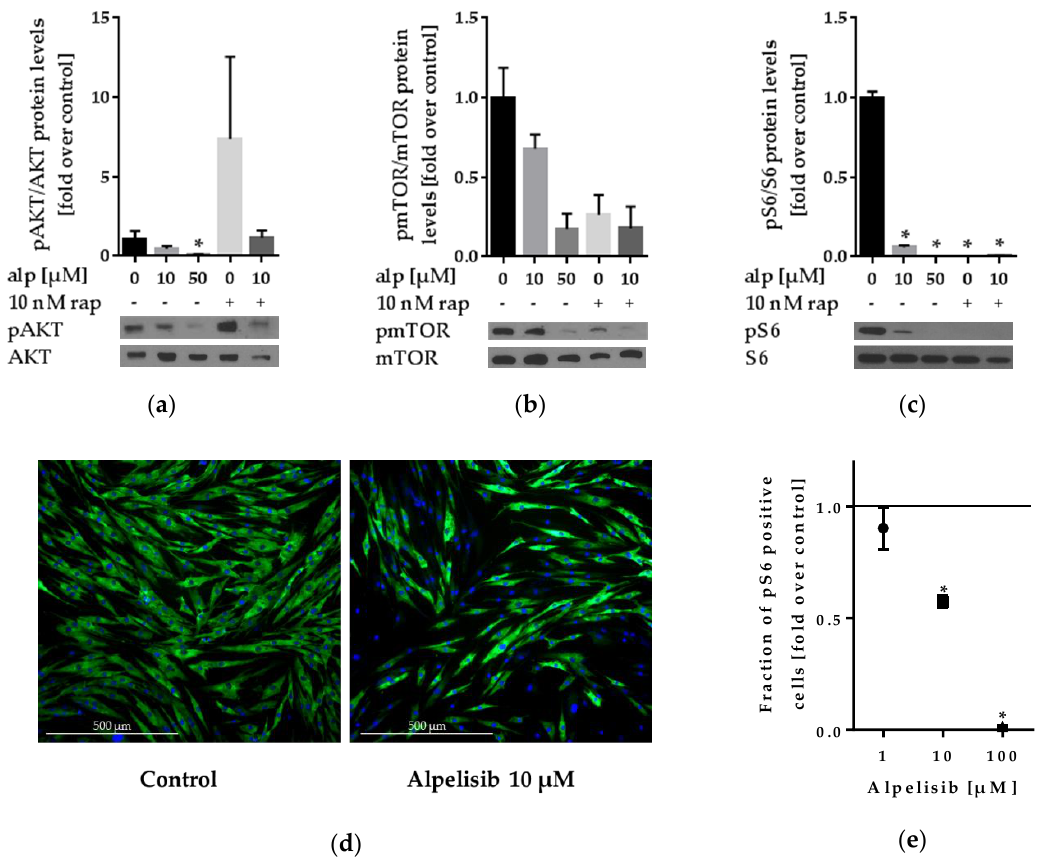
Figure 4. Western blot analysis of LipPD1 cells after 24 h treatment and pS6 immunofluorescence staining after 48 h treatment with alpelisib (alp) and/or rapamycin (rap), representative blots and densitometric analysis: ( a ) Phosphorylated AKT (phospho-Thr 308 (pAKT) normalized to total AKT) was reduced after alpelisib but not rapamycin treatment; ( b ) phosphorylation of mTOR (phospho-Ser 2448 (pmTOR) normalized to total mTOR); ( c ) phosphorylation of ribosomal protein S6 (phospho-Ser 235/236 (pS6) normalized to total S6 protein) was reduced after alpelisib and rapamycin treatment. One representative blot out of three for each protein (phosphorylated and total) and densitometric analysis of three independent experiments is shown, fold over solvent control, * p ≤ 0.05. ( d ) Merged image of nuclei (blue) and pS6 (green) immunofluorescence staining for untreated and 10 µ M alpelisib-treated cells; ( e ) fraction of pS6 positive cells decreased after alpelisib treatment, fold over solvent control (black line), n = 3, * p ≤